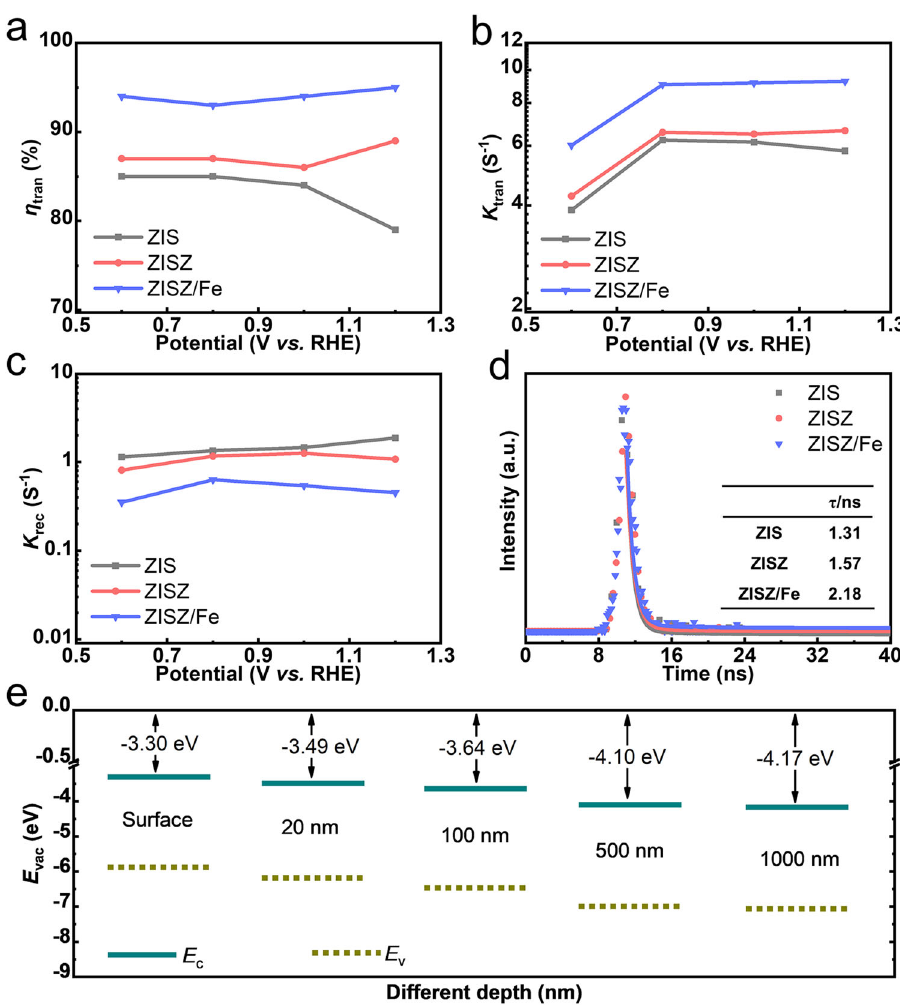
Fig. 4 Charge transfer kinetics and energy band structure. a The η tran . b The K tran . c The K rec . d TRPL decay spectra of ZIS, ZISZ, and ZISZ/Fe (the inset is calculated carrier lifetime). e The energy level diagram of ZISZ/Fe with different etching depth obtained from UPS results ( E c: conduction band; E v: valence